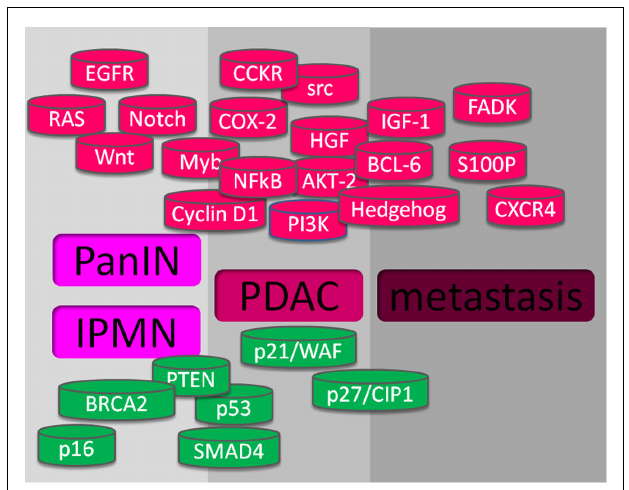
FIGURE 1 |Altered genes in pancreatic cancer. At the upper part, in red, are shown the gene alterations with gain-of-function, and at the lower part, in green, are showed the genes with lost-of-function, that promote pre-cancerous lesions PanIN and IPMN, PDAC, and metastasis.